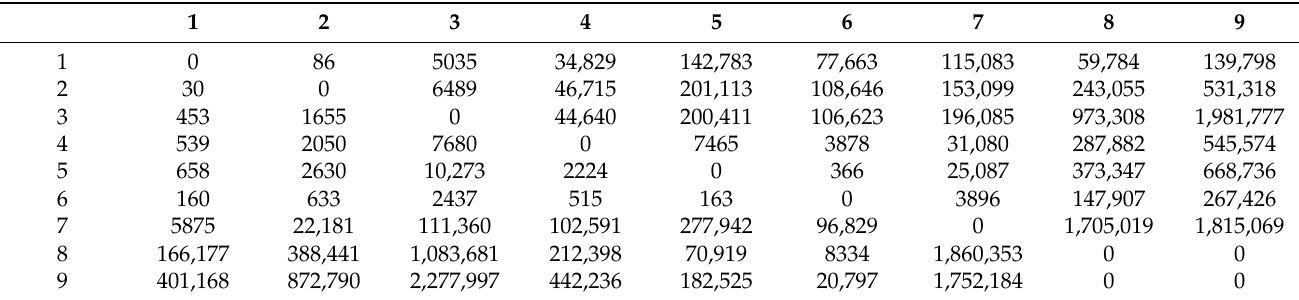
Table 6. Trip distribution of each traffic zone (number of tourists).